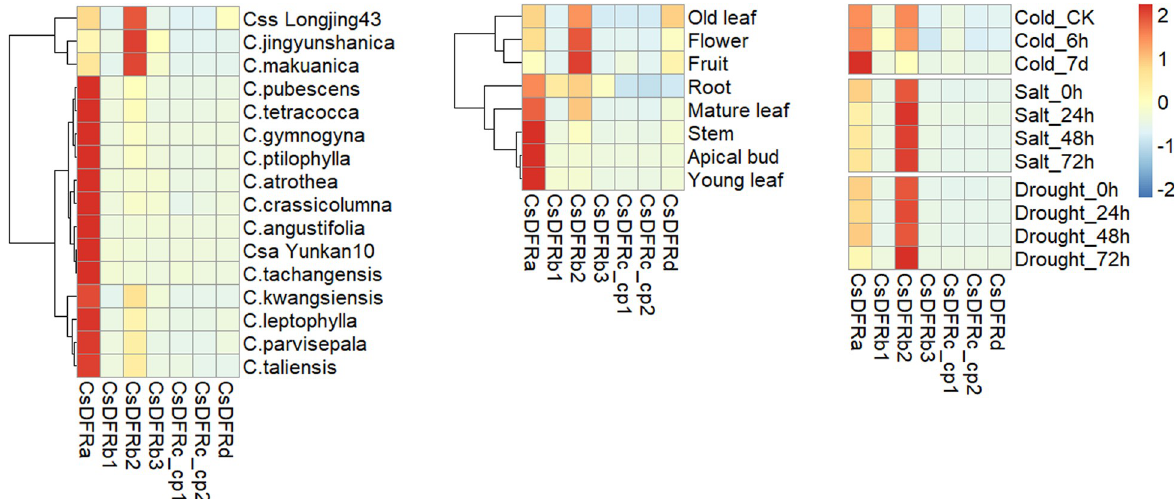
Fig 9. Expression profile of putative CsDFRs among various varieties, tissues and